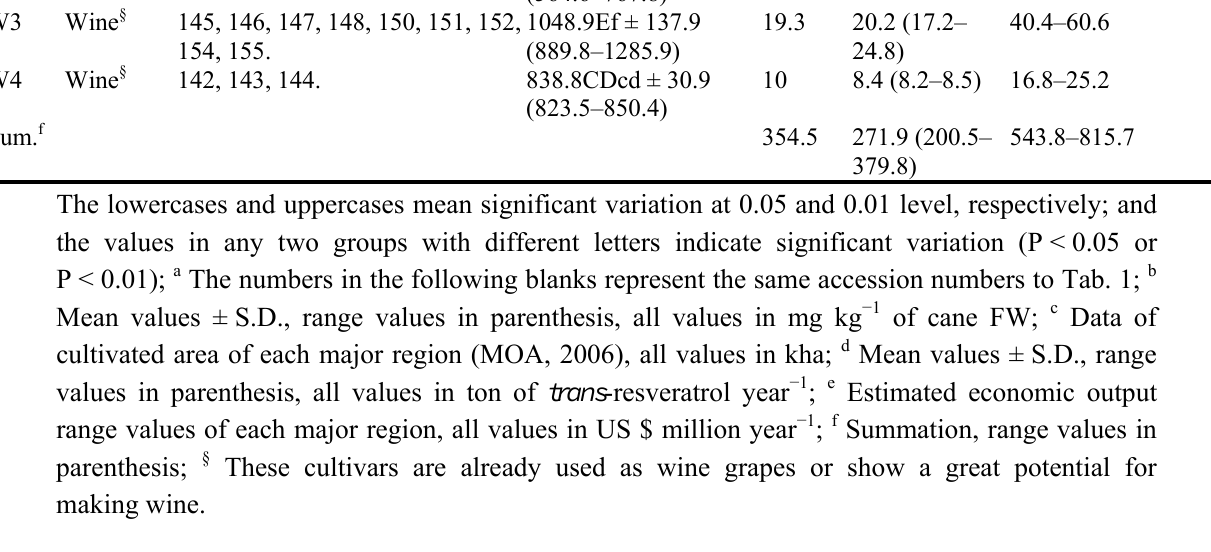
Table 4. Occurrence of trans -resveratrol in the main known